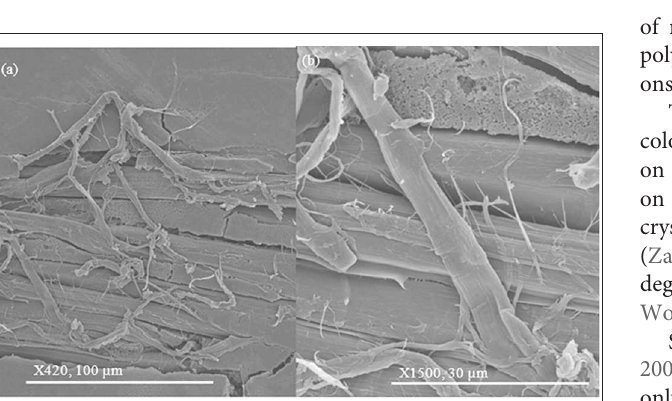
FIGURE 11 | SEM images of fine filaments developing from the flax fibers after 28 days at (a) 420X; (b) 1500X